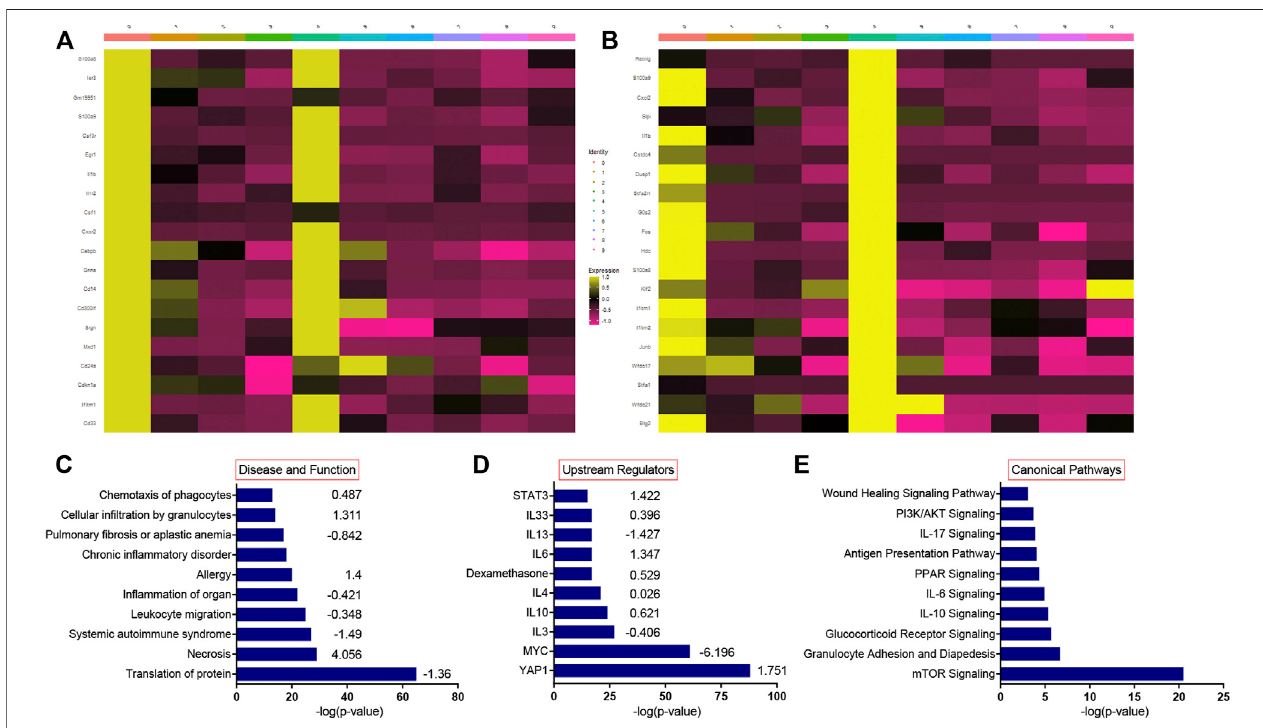
FIGURE 2 | Single-cell RNA sequencing pathway analysis during SP-C I73T induced acute in fl ammatory exacerbations. Single cell RNA-sequencing analysis was performedoncollagenasedigestedsinglecellsuspensionsfromcontrol(CTL,oiltreatedSP-C I73T mice)orSP-C I73T mice14 daysafterinjury. (A,B) Heatmapsofthetop 20 most expressed genes in the eosinophil and neutrophil cluster relative to all other clusters. (C – E) Ingenuity pathway analysis was performed for the differentially expressed genesof the eosinophil population.Graph represents 10activated pathwayswith respect to (C) disease and function, (D) upstream regulators, and (E) canonical pathways are presented with their corresponding − log(p-value) (x-axis) and predicted directionality.